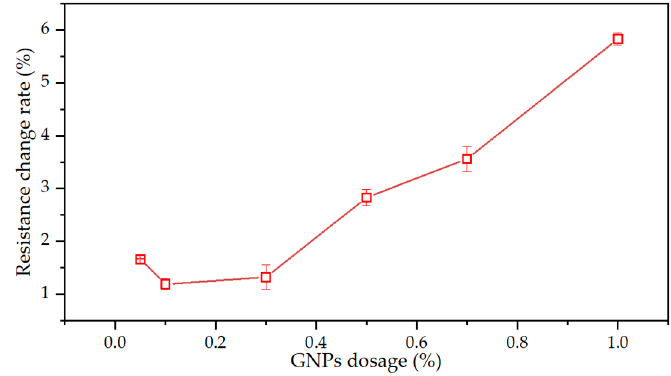
Figure 13. Pressure-sensitive property of GNPs cement mortar.